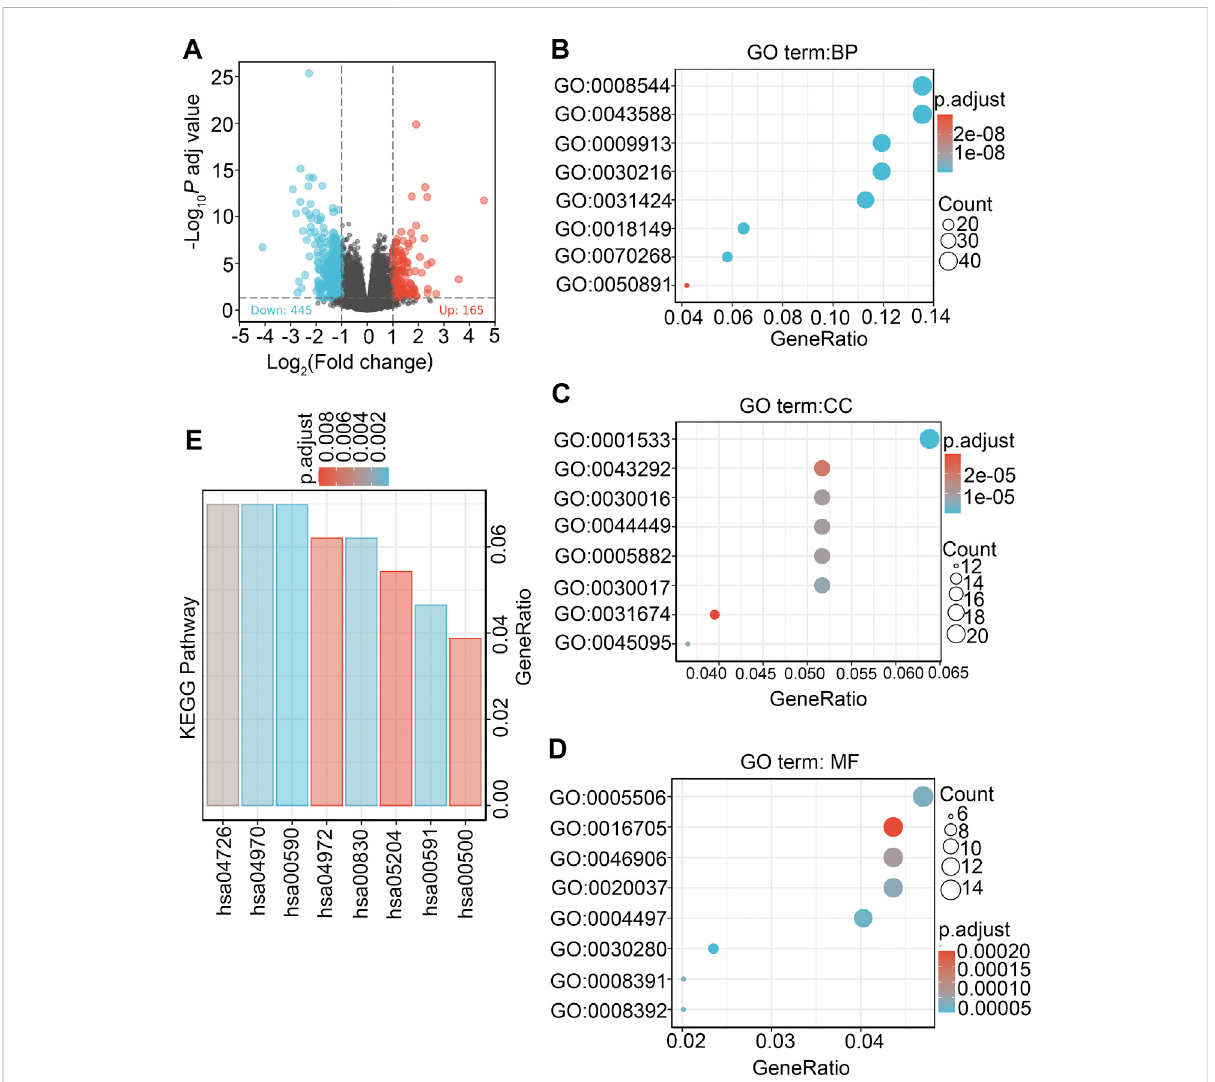
FIGURE 8 Differentially expressedgenes between patients with high and low DDX59-AS1 expression and functional enrichmentanalysis. (A) Volcano plot of differentially expressed genes between the high and low DDX59-AS1 expression groups. Normalized expression levels are shown in descending order from green to red; (B) Enriched GO terms in the biological process category; (C) Enriched GO terms in the cellular component category; (D) Enriched GO terms in the molecular function category. The x -axis represents the proportion of differentially expressed genes (DEGs) and the y -axis represents different categories. Blue and red tones represent adjusted p values from 0.0 to 0.05, respectively, and different circle sizes represent the number of DEGs; (E) Enriched KEGG terms in the biological process